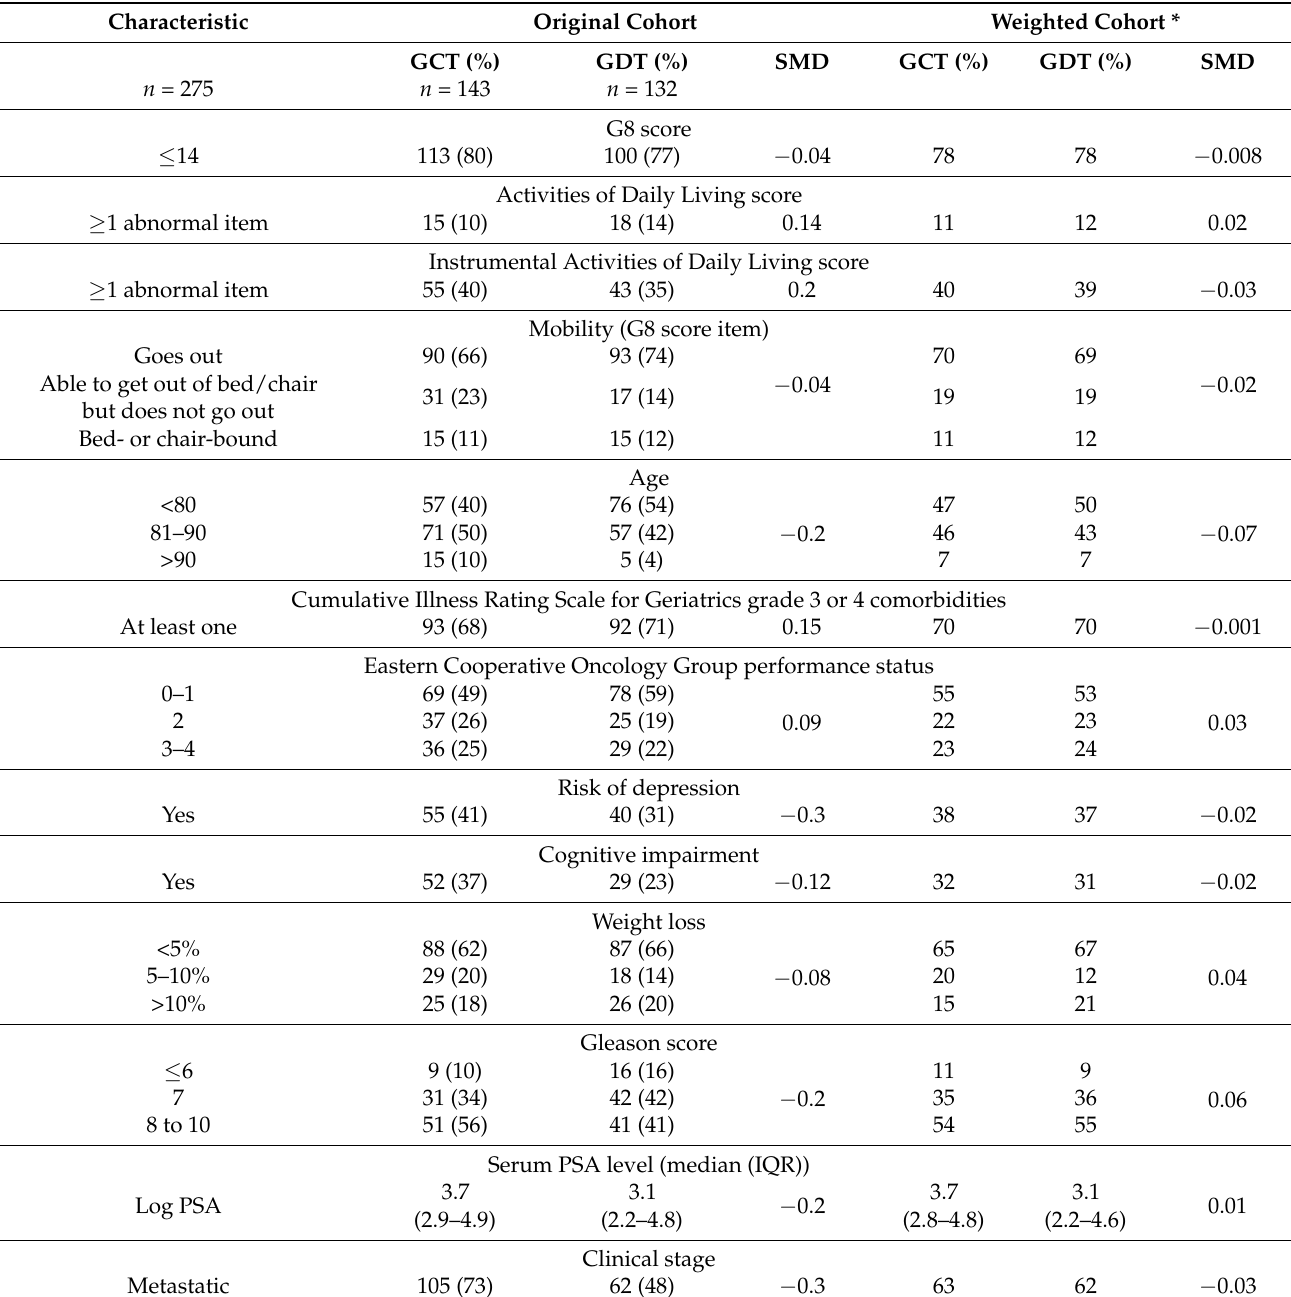
Table 2. Baseline characteristics of the patients included in survival analyses before and after